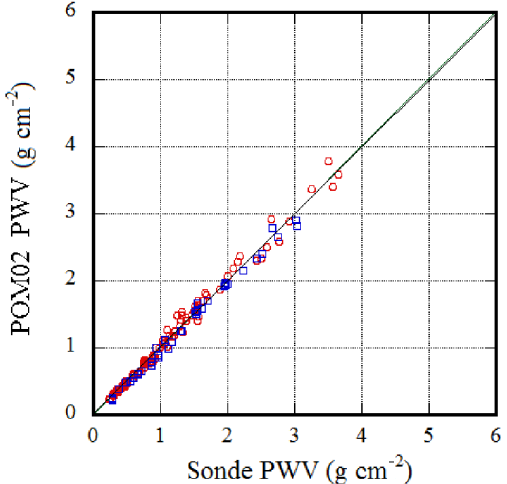
Figure 10. Same as Fig. 9 except for corrected POM-02 precipitable water vapor.